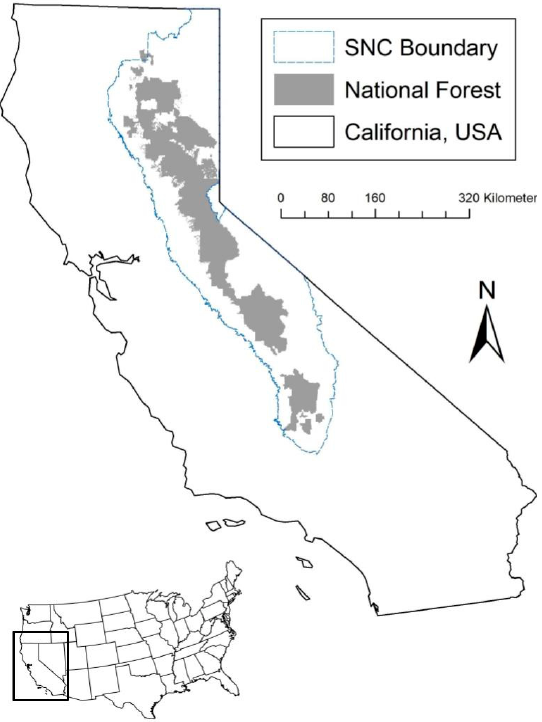
Figure 1. Study area in the Sierra Nevada Mountains of California, USA. The Sierra Nevada Con- servancy (SNC, https://sierranevada.ca.gov/) boundary indicates the extent of the study region, and the shaded area indicates locations within the ownership boundaries of USDA Forest Service national forest lands.